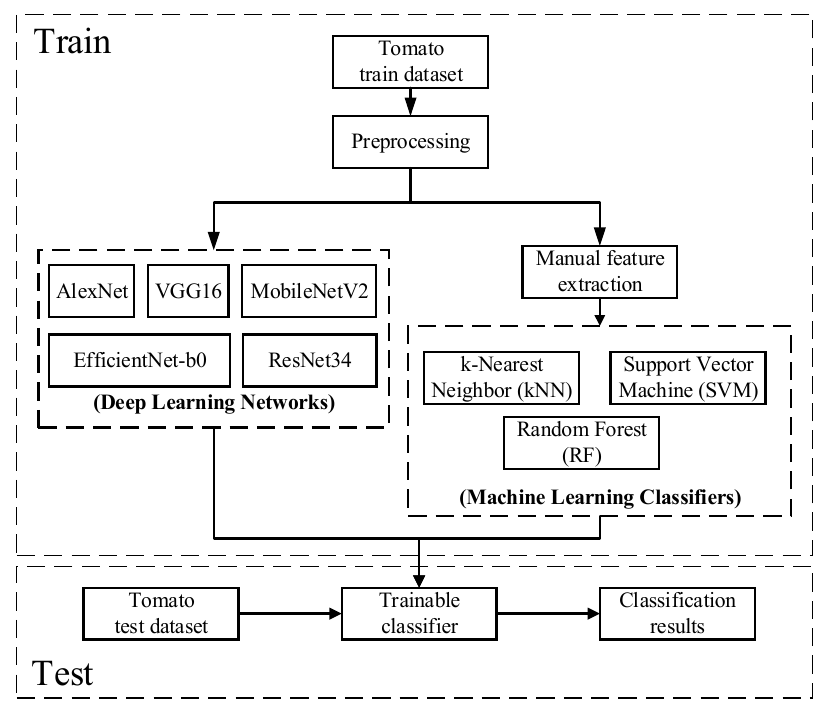
Figure 6. Flowchart of tomato disease classification. Our implementation was based on the PyTorch framework and PyCharm Integrated Development Environment. The experiment was conducted on a single-CPU/single-GPU platform; the models of the CPU and GPU were an Intel (R) Core (TM) i5-9400F CPU @ 2.90GHz and an NVIDIA GeForce RTX 2060 SUPER,